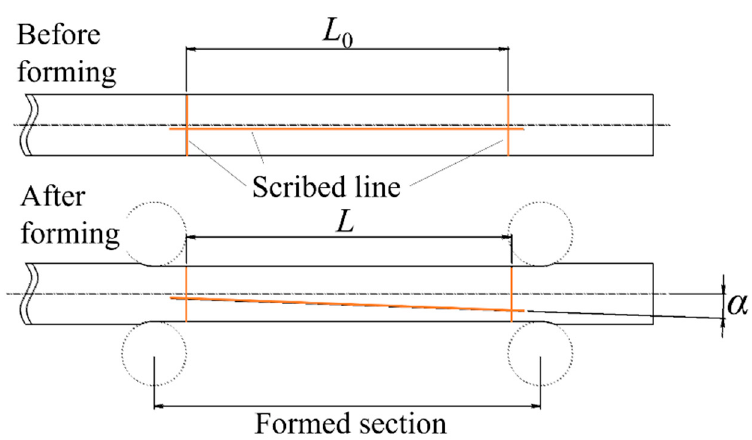
Figure 3. Schematic diagram of scribe lines on the tube.